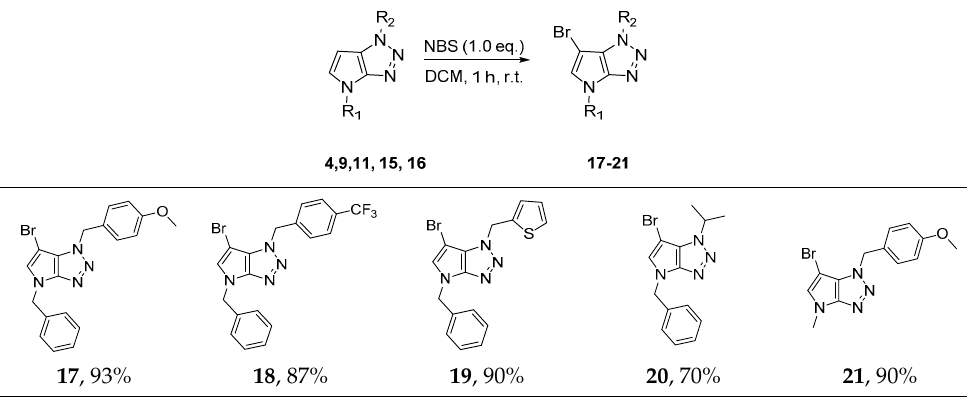
Table 3. C-6 bromination of pyrrolo[2,3- d ][1,2,3]triazoles: s ynthesis of 17 – 21 a .